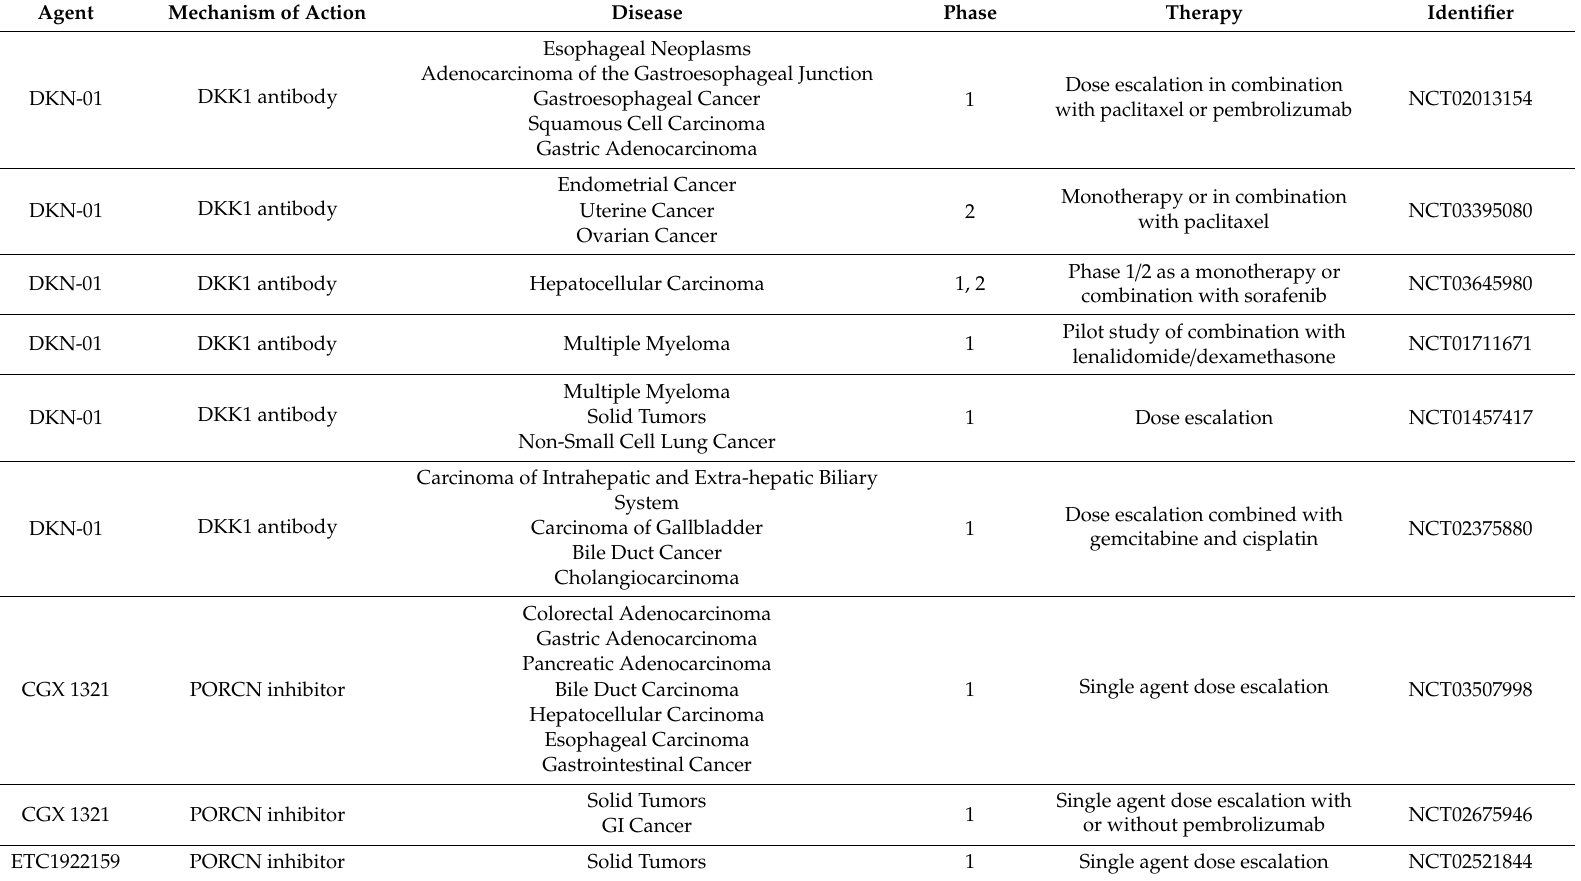
Table 1. Cancer Clinical Trials of Wnt Modulators. Agents used are listed with the mechanism of action, the corresponding investigated disease, the phase of the trial, the investigational intervention, and the clinical trial identifier